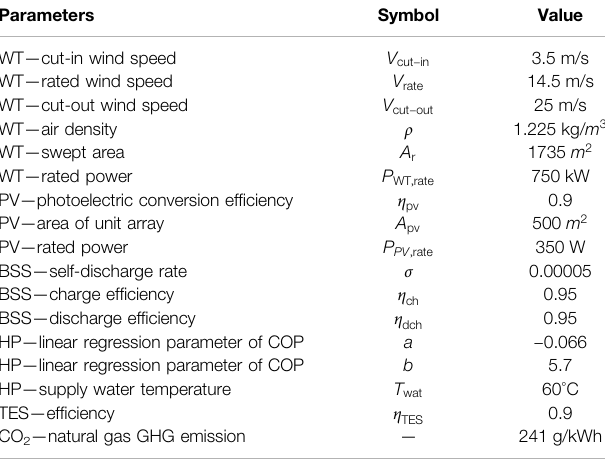
TABLE 1 | Model parameters of components in renewable heating system.